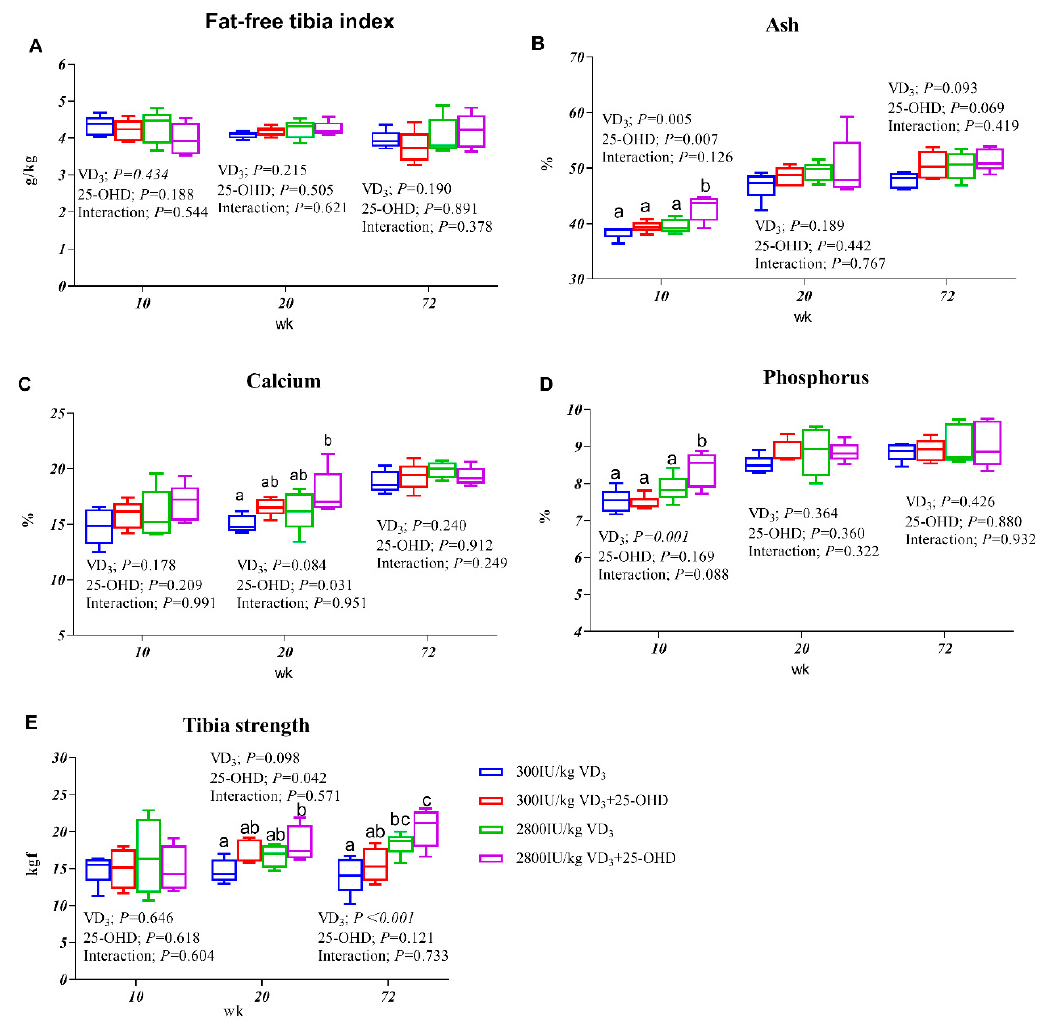
Figure 3. Effects of dietary VD 3 level and 25-OHD on tibia quality. ( A )Fat-free tibia index; ( B ) Ash content in tibia; ( C ) Calcium content in tibia; ( D ) Phosphorus content in tibia; ( E ) Tibia strength. a–c Mean values with different letters are significantly